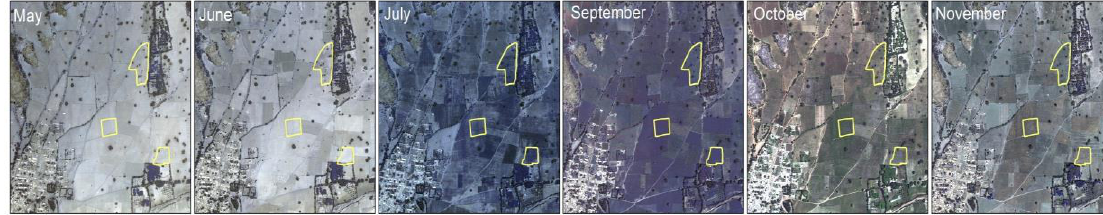
Figure 5. The temporal evolution of individual farms as depicted from true-colour composite VHSR satellite data within the growing season in Sukumba, Mali.